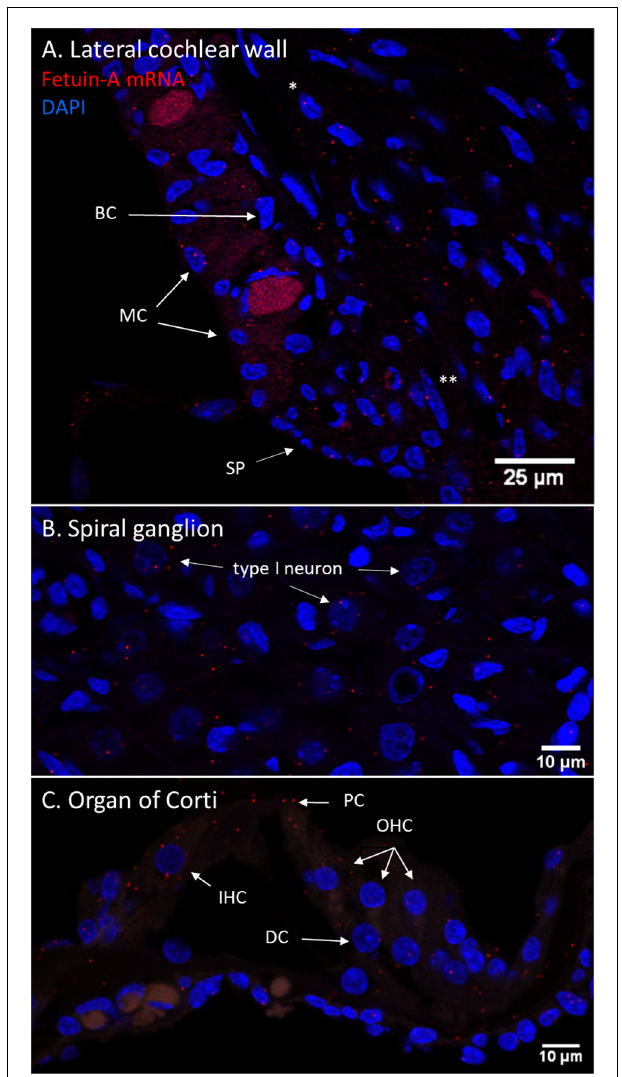
FIGURE 11 | Fetuin-A m-RNA in the guinea pig cochlea. (A–C) RNAscope of Fetuin-A mRNA in the control guinea pig cochlea. Red dots indicate mRNA transcripts. DAPI staining of nuclei. Spiral prominence (SP); Marginal cell (MC); Basal cell (BC); type I fibrocytes ( ∗ ); type II fibrocytes ( ∗∗ ). (A) Fetuin-A mRNA was detected in all cell layers of stria vascularis, spiral ligament, and prominence. (B) The spiral ganglion type I neurons had Fetuin-A mRNA transcripts, but in small numbers. (C) In the guinea pig organ of Corti was Fetuin-A mRNA transcripts detected in the IHCs, OHCs, Deiters cells (DC), and pillar cells (PC). PEDF mRNA in the guinea pig